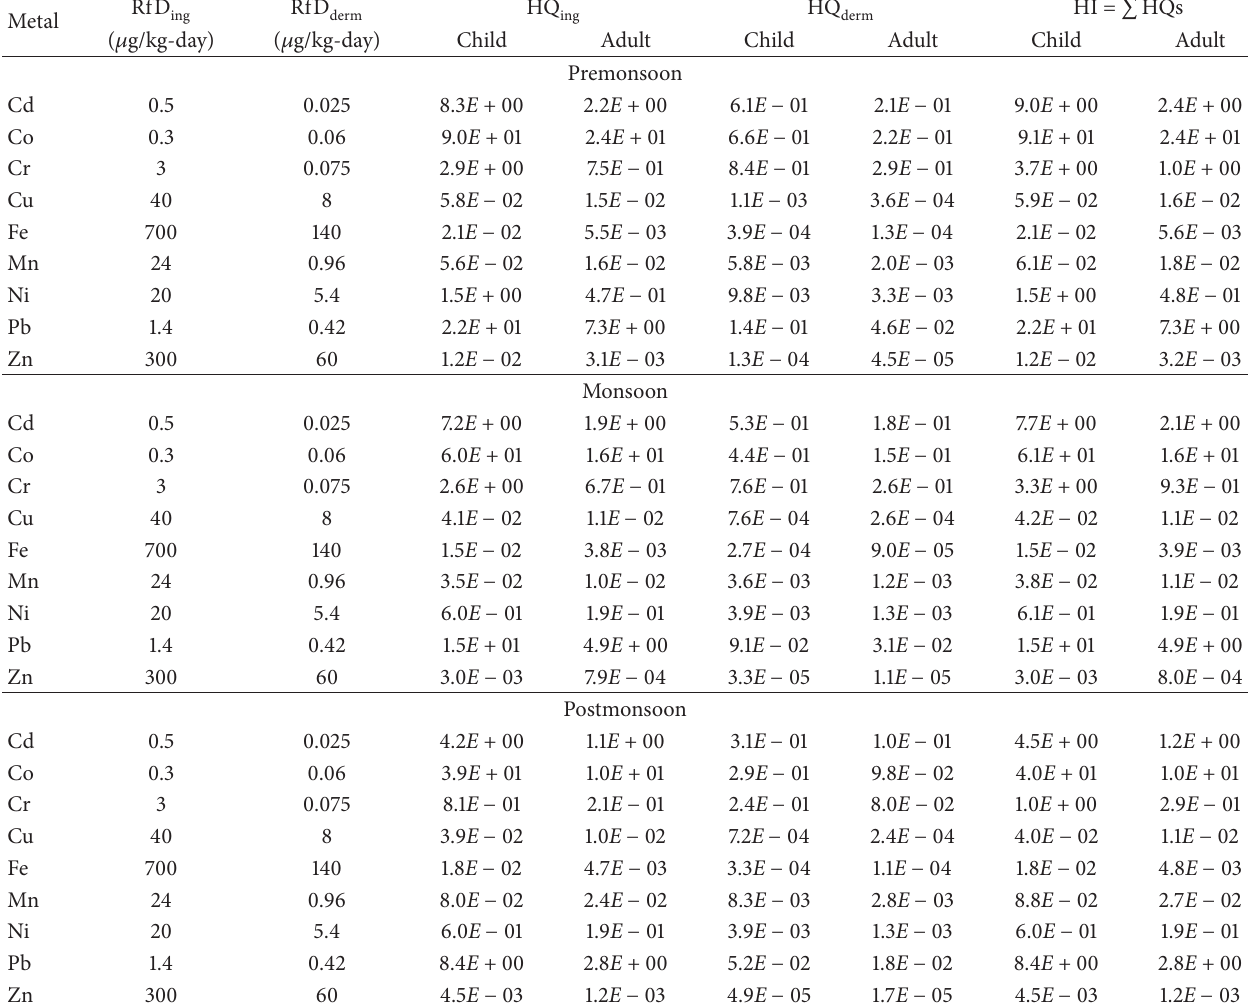
Table 5: Hazard quotient (HQ) and hazard index (HI) for each metal in surface water of Mangla Lake.